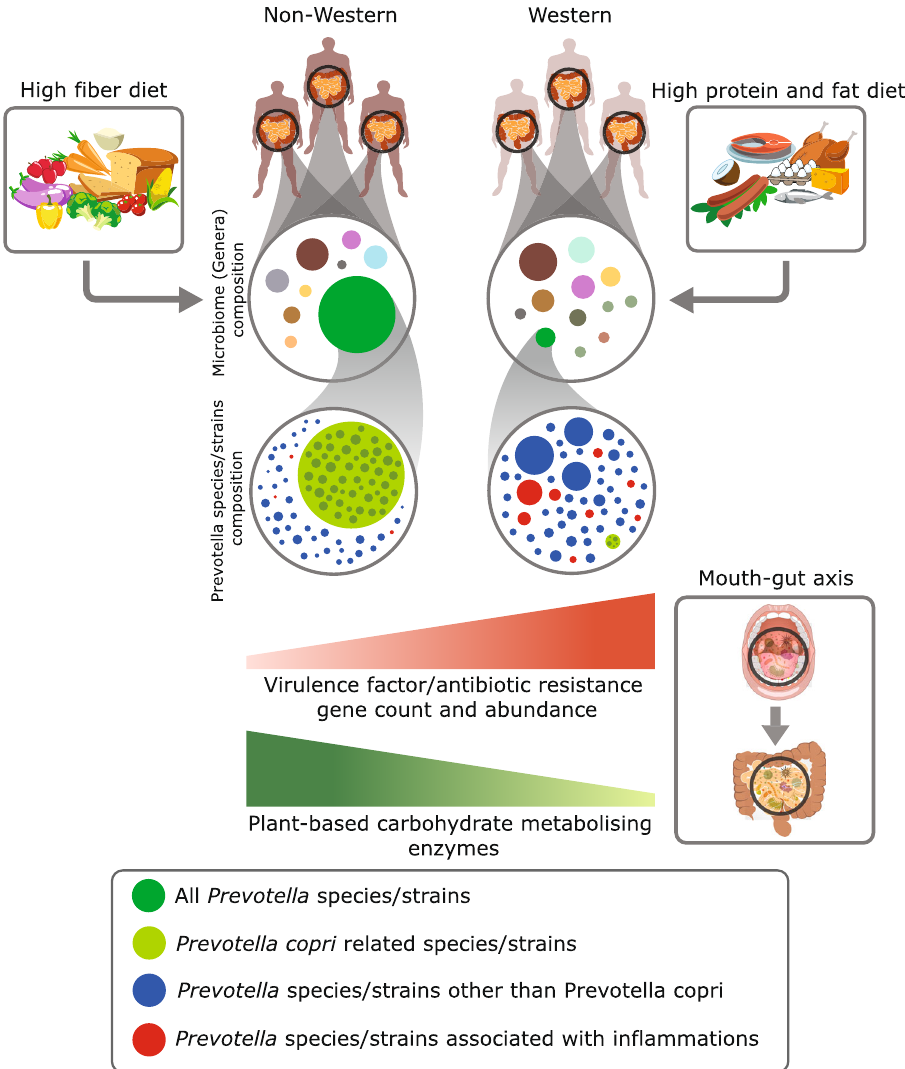
Fig. 8 Impact of Prevotella composition on human health. Schematic representation of taxonomic and functional composition of Prevotella species in western and non-western populations is